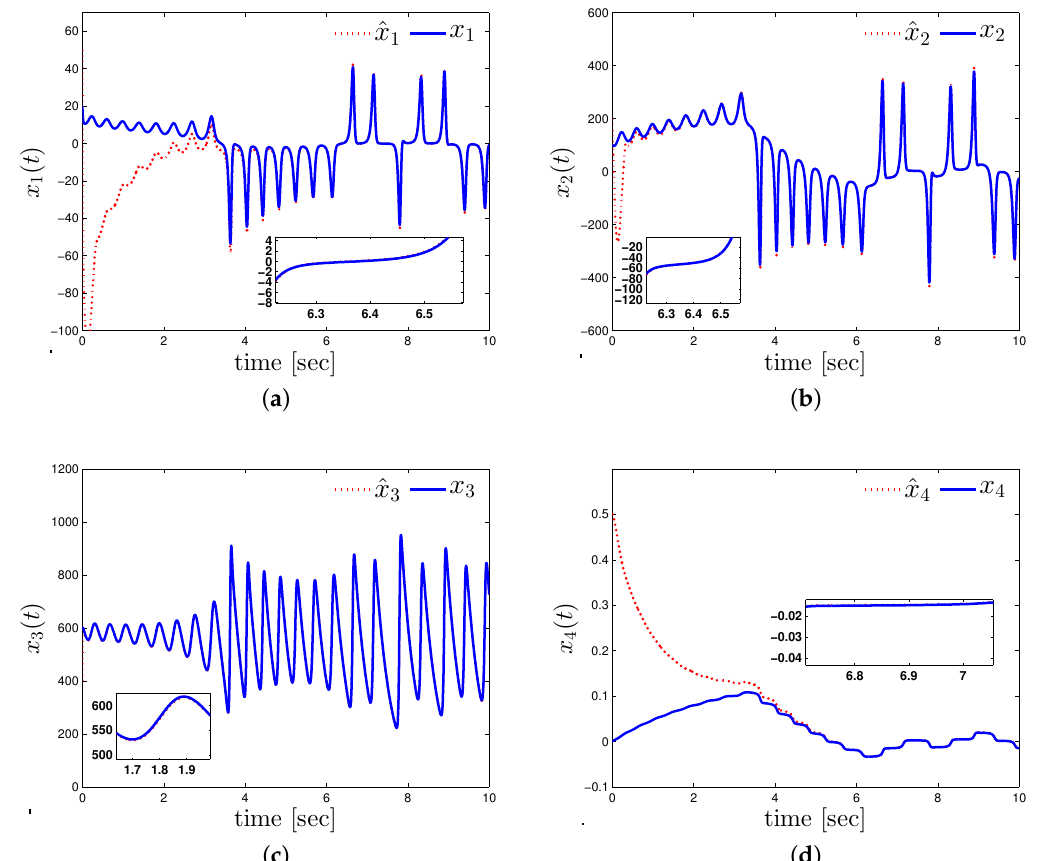
Figure 4. Actual (solid line) and estimated (doted line) values: ( a ) Dynamic of state x 1 and its estimated ˆ x 1 . ( b ) Dynamic of state x 2 and its estimated ˆ x 2 . ( c ) Dynamic of state x 3 and its estimated ˆ x 3 . ( d ) Dynamic of state x 4 and its estimated ˆ x 4 .